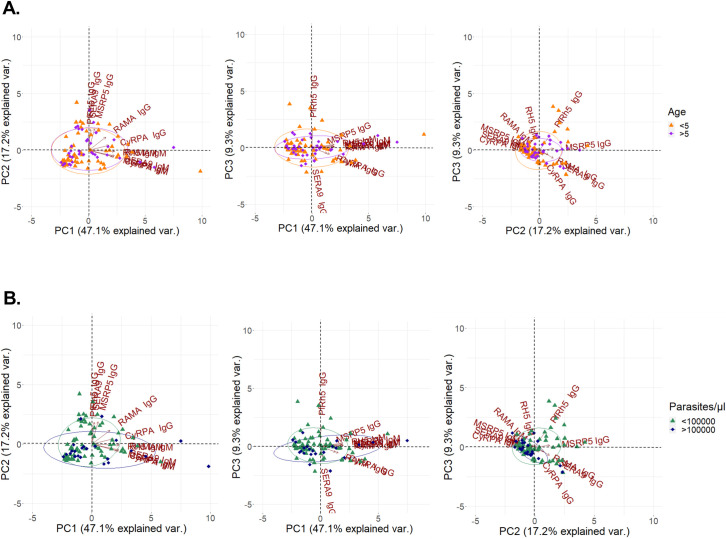
Principal components analysis (PCA) of antibody responses in subjects with acute P. falciparum malaria.Panels A and B show the plots of the distribution of individuals (SM and UM subjects). The first three principle components (PC1, PC2 and PC3), explaining the greatest variance, were chosen for representation, and include all antigen and antibody combinations tested. Panel A is grouped by age (<5; orange, >5; purple) whereas panel B is grouped by parasitemia (<100000 parasites/μL; green, >100000 parasites/μL; navy).